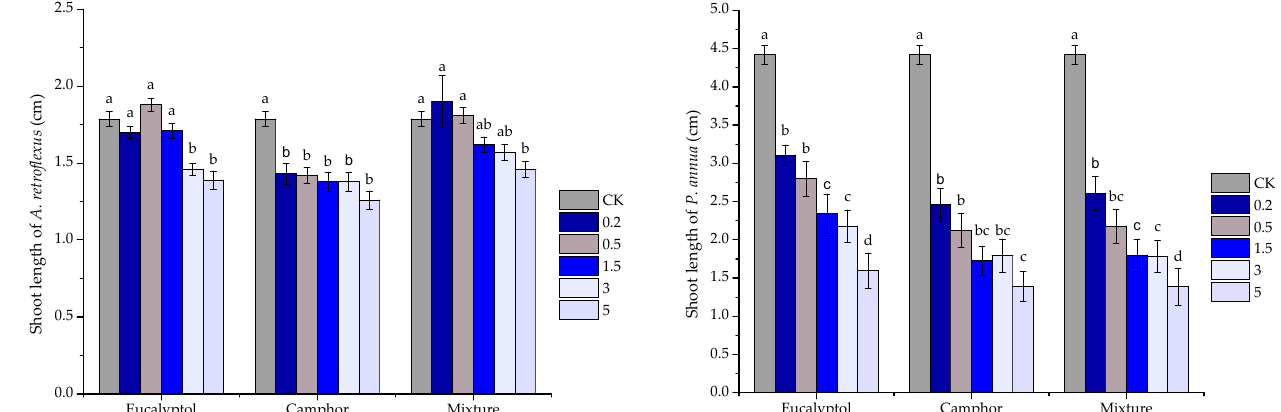
Figure 4. Phytotoxic effect of eucalyptol, camphor and their mixture at different concentrations (0 mg/mL(CK), 0.2 mg/mL, 0.5 mg/mL, 1.5 mg/mL, 3 mg/mL and 5 mg/mL) on root elongation of A. retroflexus and P. annua . Each value is the mean of five replicates ± SE ( n = 50). Means with different letters (a, b, c, etc.) indicate significant differences at p < 0.05 level according to Fisher’s LSD test.